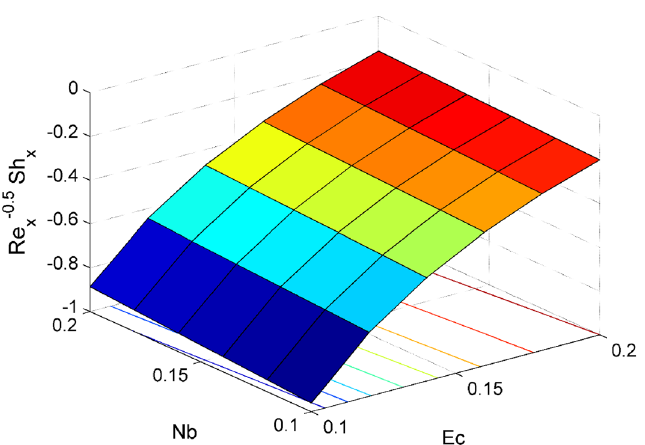
Figure 19. Effect of Nb and Ec on Re − 0.5 x Sh x .